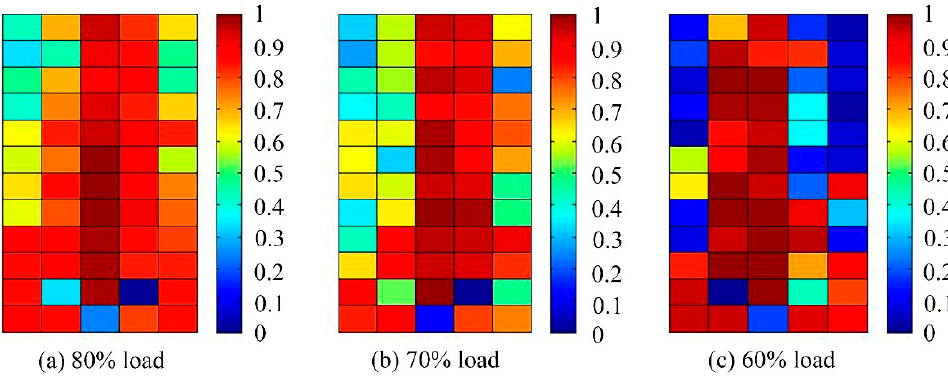
Figure 18. Probability distribution contours of the over-limit load.